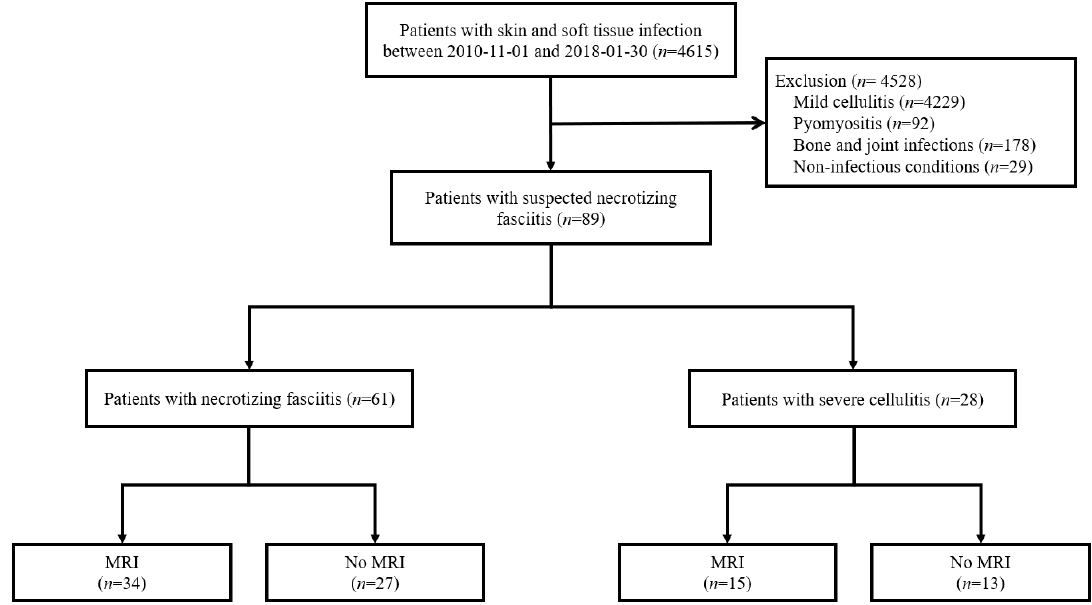
Figure 1. Flow diagram of the study. Abbreviations: MRI = magnetic resonance imaging.